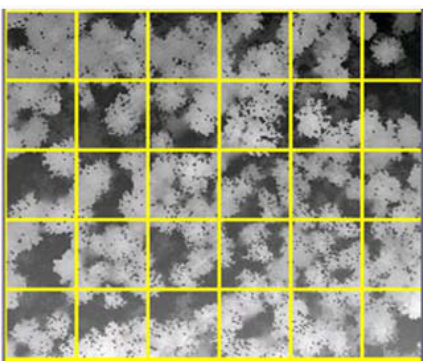
Figure 5. Divided cells (30) in yellow color overlaid on the